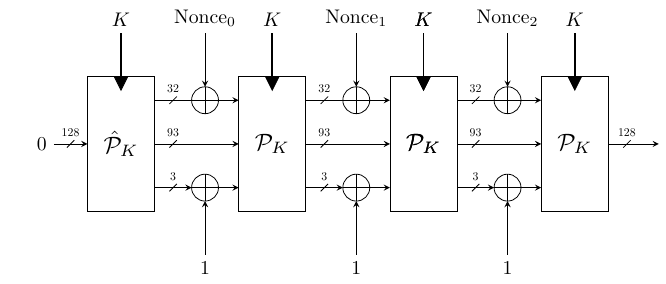
Figure 4: The initialization process of TinyJAMBU